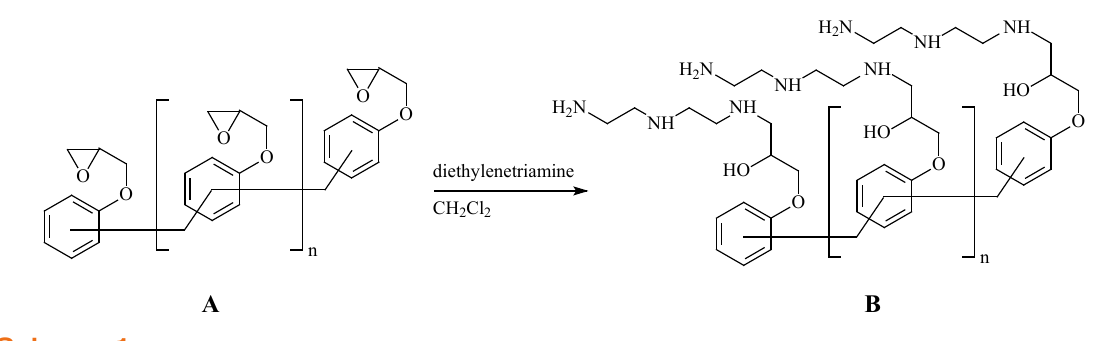
Scheme 1. Single stage synthesis of the matrix.